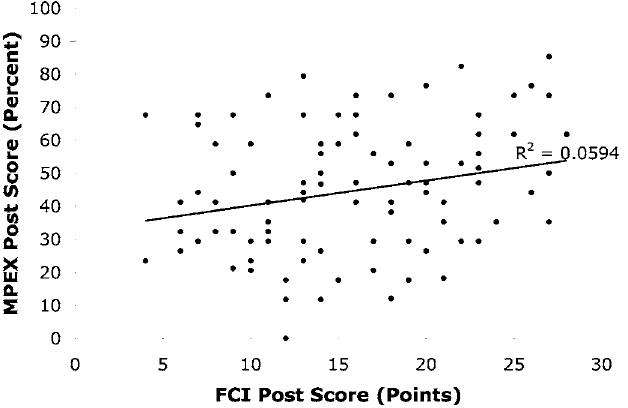
FIG. 5. Correlation of the final FCI score with the MPEX score ( R =0.24 (cid:3) 0.04 → 0.42 (cid:4) (cid:1) n =97 (cid:2)